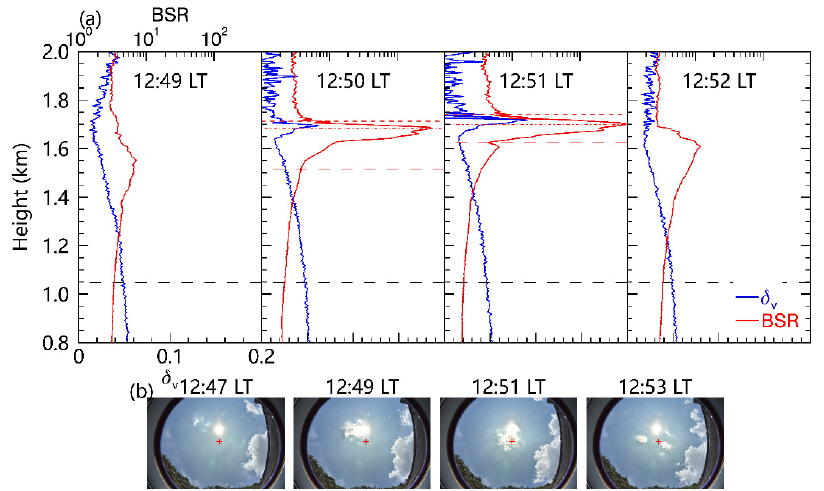
Figure 5. Same as Figure 3, but for a short-duration cumulus cloud event during 12:49–12:52 LT on the 31st of July, 2019. ( a ) Profiles of lidar backscatter ratio (R, red) and volume depolarization ratio ( δ V , blue). ( b ) Photographs of the sky recorded by a ground-based camera. Note that this cumulus cloud formed and vanished in a time scale of 1–2 min.